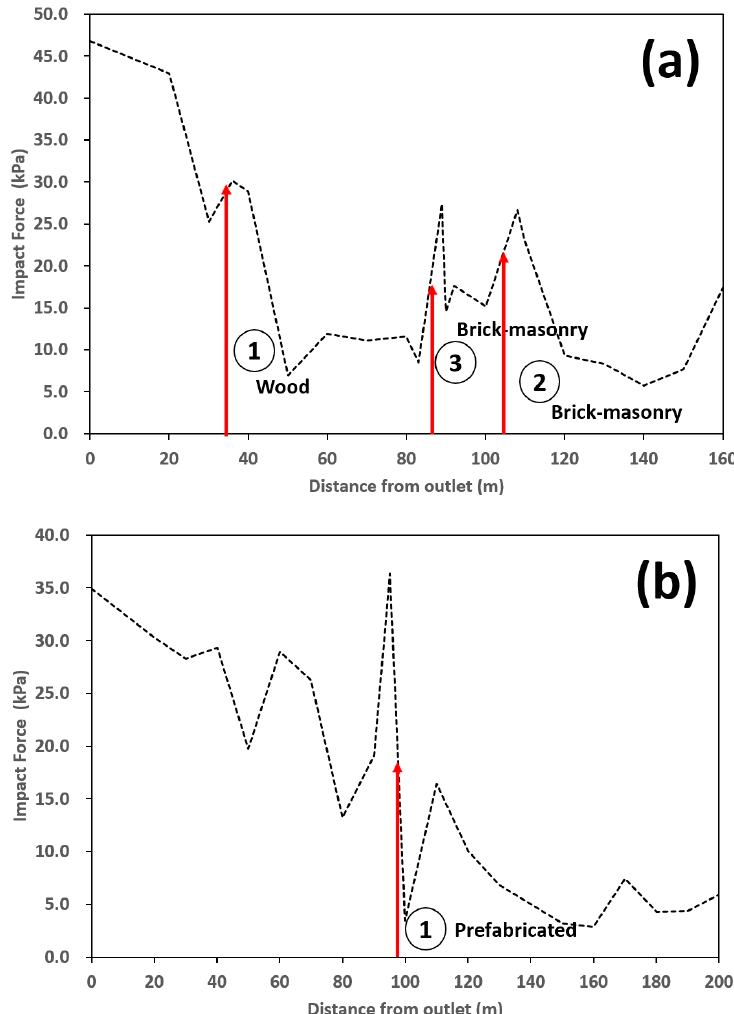
Figure 5. Analysis of debris flow impact forces varying with distance from outlet, based on FLO-2D simulation: ( a ) The graph shows the changing impact forces of debris flow for Site A, and the locations of damaged buildings are marked with the numbers ① , ② , and ③ . ( b ) The graph shows the changing impact forces of debris flow for Site B and the location of the building having been damaged from the debris flow marked with the number ① , and the construction material is shown. Table 2. Calculation of impact force from the outlet and the description of the damaged building.